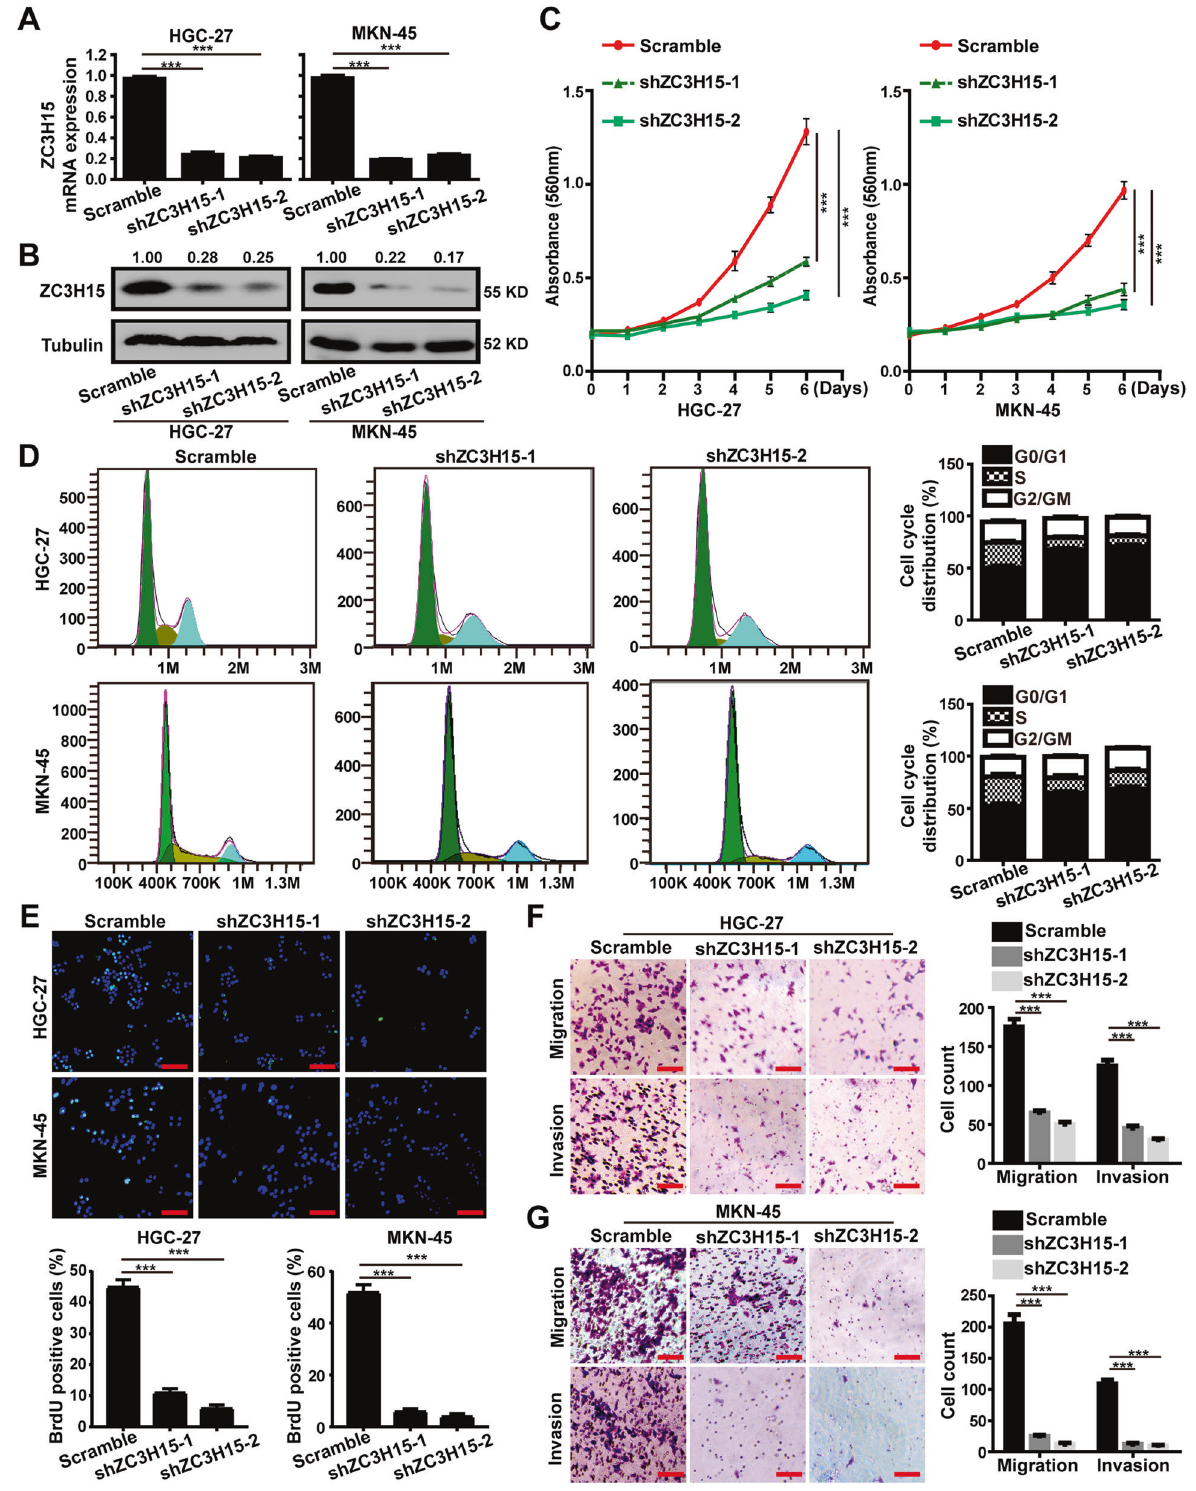
Fig. 2 ZC3H15 knockdown inhibited the cell proliferation, migration, and invasion of GC cells. A The expression of ZC3H15 mRNA in ZC3H15-knockdown and control cells were detected by RT-PCR analysis. B The expression of ZC3H15 protein in ZC3H15-knockdown and control cells were detected by western blot analysis. C MTT assays were performed on stably transfected ZC3H15-knockdown and control cells. D Flow cytometry assays were performed to quantify the cell population in each phase of the cell cycle. E BrdU staining assays were performed to detect the amount of DNA synthesis in ZC3H15-knockdown HGC-27 and MKN-45 cells. F , G Transwell assays were used to detect the migration and invasion ability of GC cells. All data were expressed as mean ± SD. Student ’ s t -test was performed to analyzed signi fi cance, * P < 0.05, ** P < 0.01, *** P < 0.001.